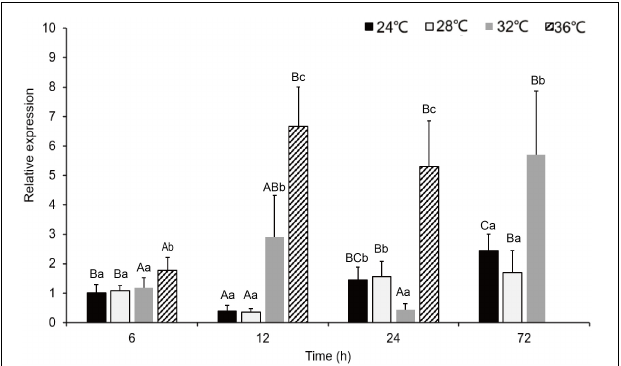
FIGURE 6 | The expression levels of PmHSP70 mRNA in gill from P. maxima after acute MHWs stress. Small letters indicate significant differences between four temperature levels within each time, and capital letters indicate significant difference between four time within each temperature treatment ( P < 0.05). As pearl oysters exposed to the temperature anomaly of 36 ◦ C suffered 100% mortality at 24 h, the experiment was terminated accordingly.